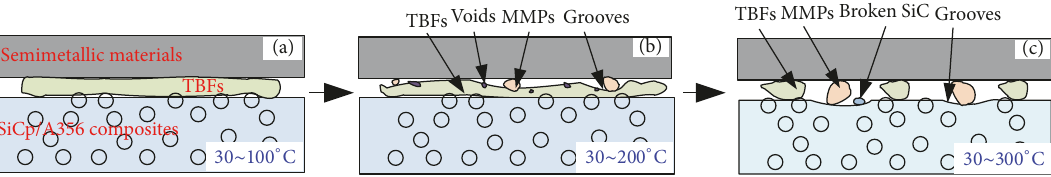
Figure 15: The transformation process of temperature effect on the surface third body films (TBFs) of dry friction: (a) 30 ∘ C ∼ 100 ∘ C, (b) 30 ∘ C ∼ 200 ∘ C, and (c) 30 ∘ C ∼ 300 ∘